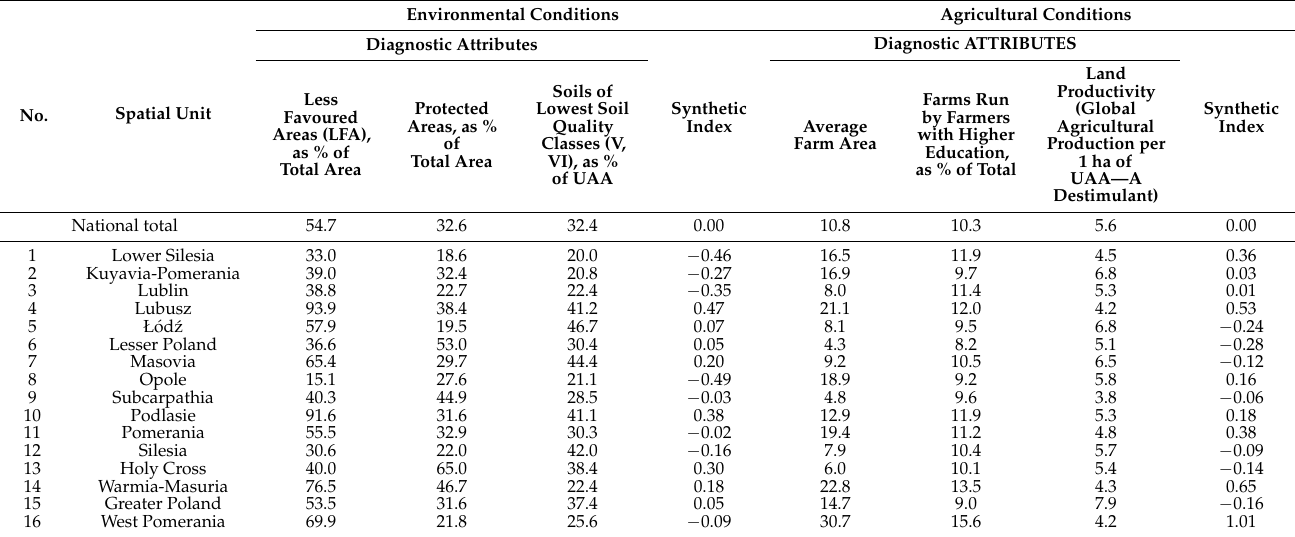
Table 1. Selected determinants of green development of Polish agriculture.